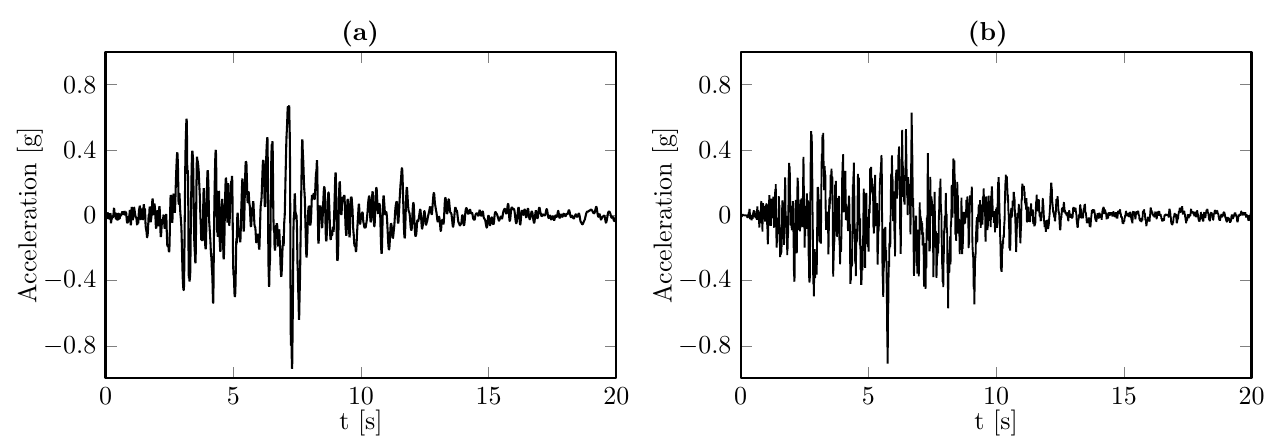
Figure 3. ( a ) Accelerogram of the Northridge earthquake [35] in 1994 and ( b ) time history of one sample of the synthetic generated accelerograms using a nonstationary Kanai–Tajimi filter.